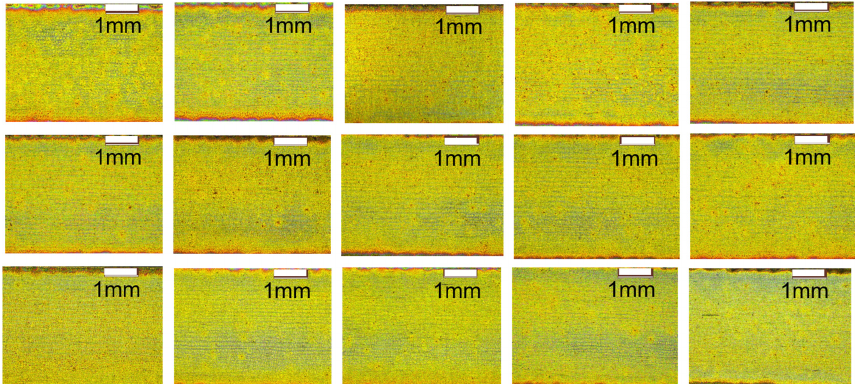
Figure 12. Optical characterization of the 100 m length SDP ‐ Y 2 O 3 sample. From the top left to the bottom right correspond to the sequential optical characterization of the 100 m length SDP ‐ Y 2 O 3 . Each micrograph was approximately taken each 7 cm.